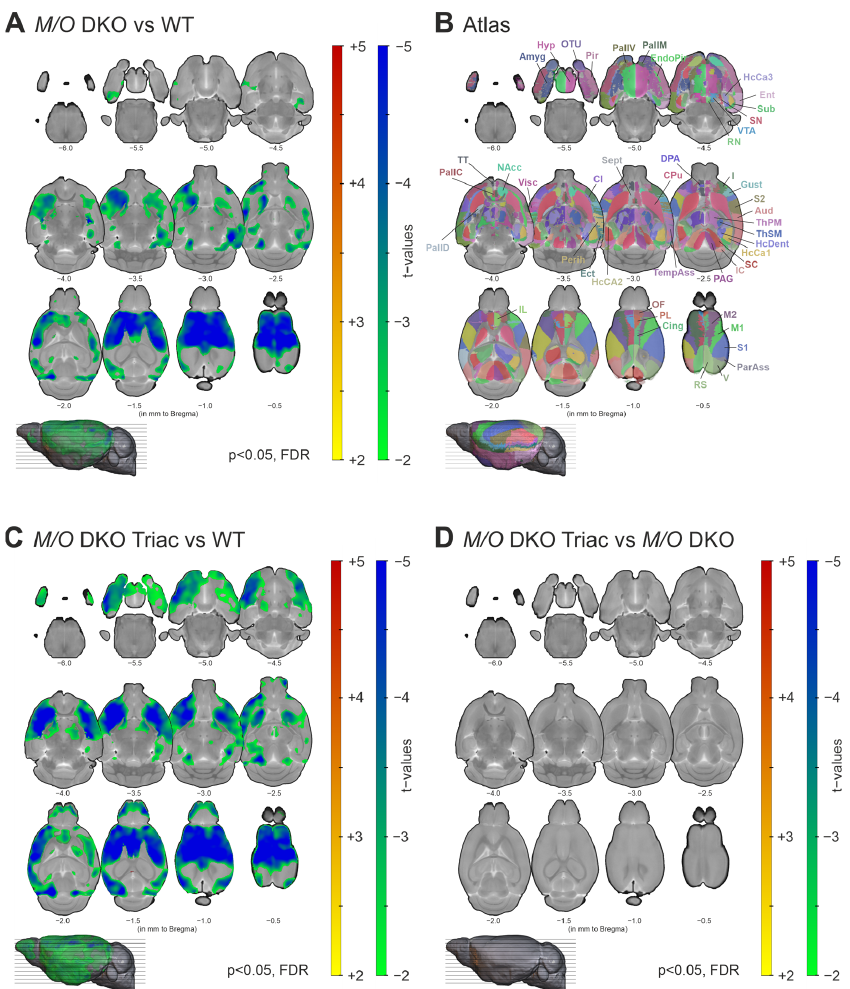
Figure 1. The differences in grey matter volume between WT, Mct8/Oatp1c1 DKO and Mct8/Oatp1c1 DKO TRIAC mice. ( A ) Voxel-based morphometry revealed a significant loss of grey matter volume in wide-spread cortical and subcortical areas in Mct8/Oatp1c1 DKO ( N = 10) compared to WT ( N = 7) mice ( p < 0.05, FDR-corrected). ( B ) Illustrates the atlas regions of the Allen Brain Atlas (atlas.brain- map.org) applied in our study. ( C ) A highly similar pattern of decreased grey matter volume (in relation to A ) could be found comparing Mct8/Oatp1c1 DKO mice treated with TRIAC to WT mice ( p < 0.05, FDR-corrected ) , while no significant group differences could be found between Mct8/Oatp1c1 DKO and Mct8/Oatp1c1 DKO TRIAC ( N = 13) mice ( D , p > 0.05, FDR-corrected). The results are derived from post-hoc two-sample t-tests and adjusted for age and overall brain size. Grey matter volume reduction in Mct8/Oatp1c1 DKO mice predominantly focus on prefrontal and sensorimotor cortical areas, the insula and the striatum. Our results indicate a lack of TRIAC treatment effects on grey matter volume reduction. WT, wildtype; M/O DKO, Mct8/Oatp1c1 double